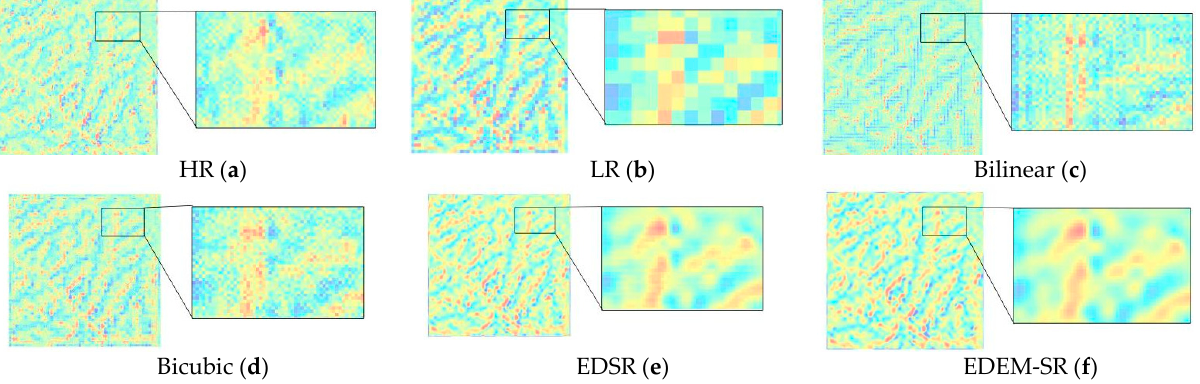
Figure 9. Example aspect maps with an up-scaling factor of 4.